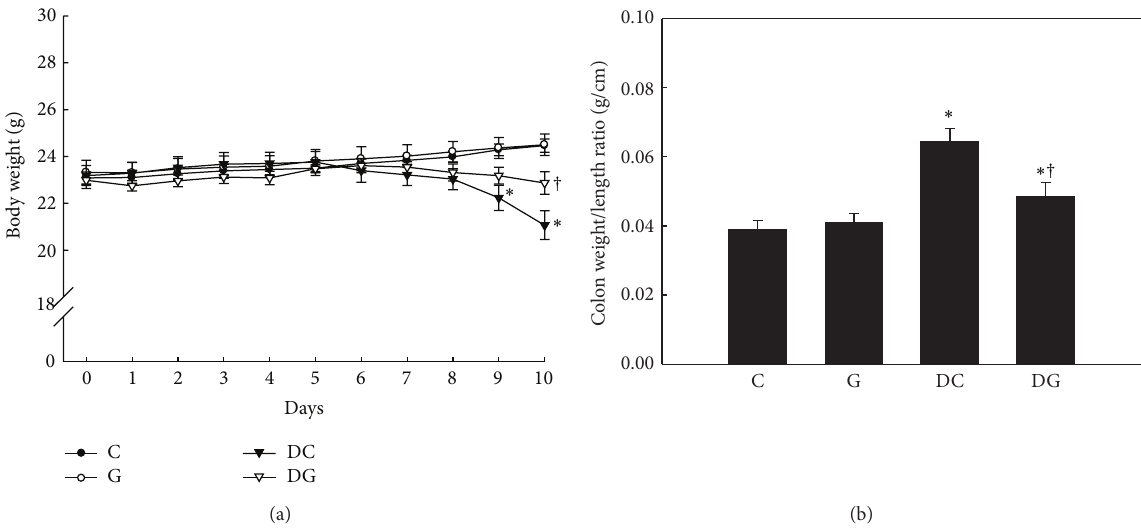
Figure 3: Body weight (a) and weight/length ratio of the colon (b). Data are presented as the mean ± SEM. C, normal mice fed the control diet; G, normal mice fed a glutamine-enriched diet; DC, DSS group fed the control diet; DG, DSS group fed a glutamine-enriched diet. ∗ Significantly different from the C group ( 𝑃 < 0.05 ). † Significantly different from the DC group ( 𝑃 < 0.05 ).